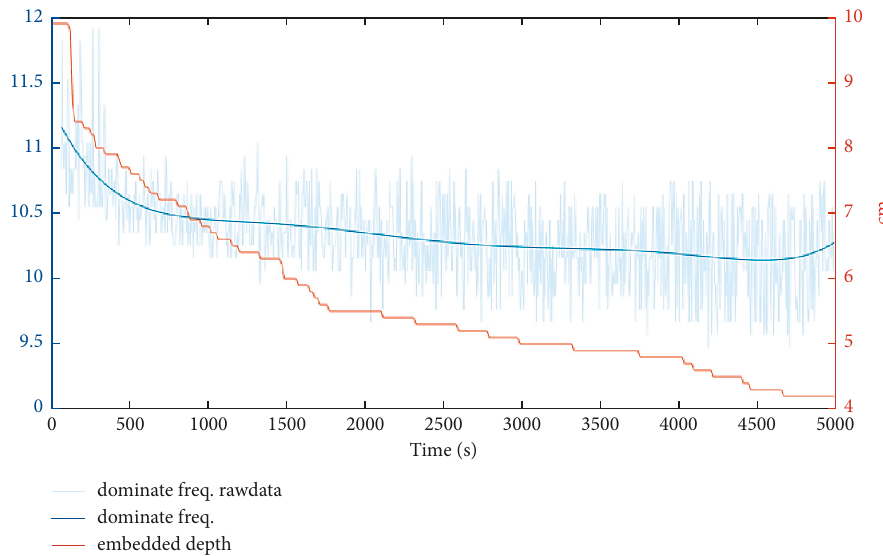
Figure 6: Dominant frequency and corresponding embedded depth.